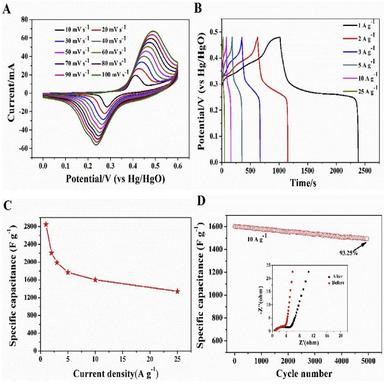
(A) CV curves at different scan rates from 10 to 100 mV s1 , and (B) charge/discharge curves of the MnNi2O4 electrode at various current densities from 1 to 25 A g1 . (C) Specific capacitance of the MnNi2O4 electrode. (D) Cycling stability of the MnNi2O4 electrode at a current density of 10 A g1 ; the inset presents Nyquist plots of the MnNi2O4 electrode before and after cycling.